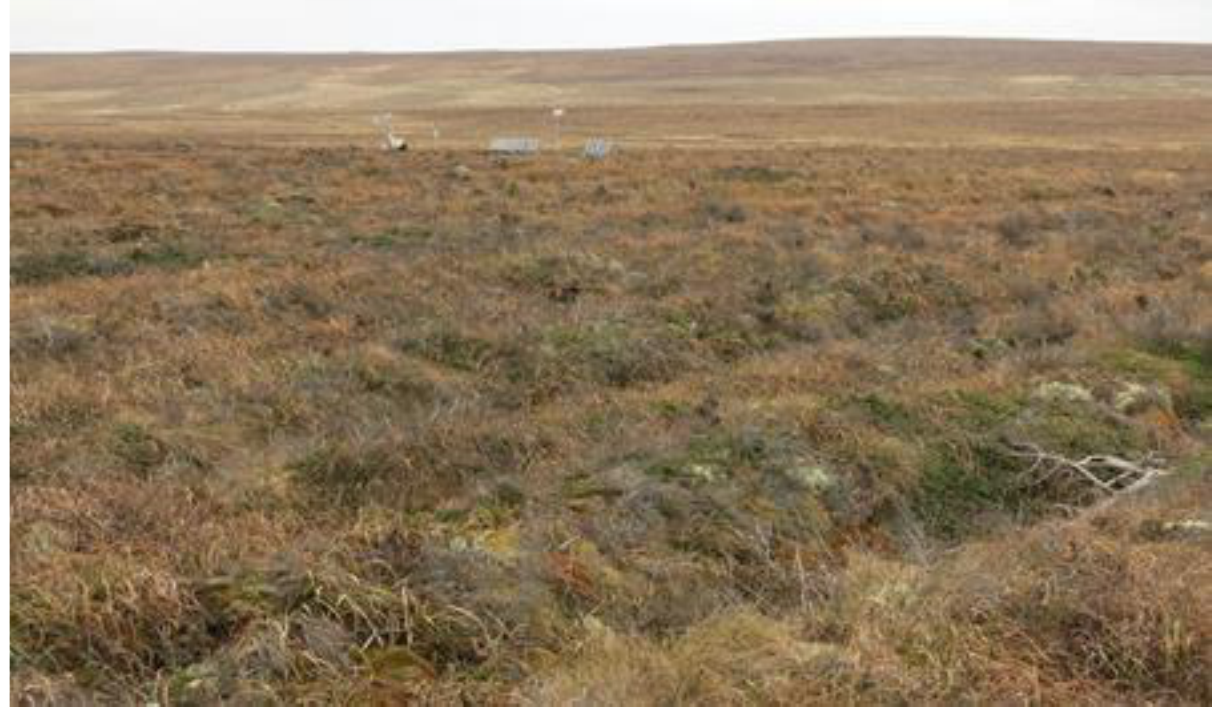
Figure 2. The Talaheel site with taller vegetation, such as Eriophorum spp. , present on the site . The microtopography on the site is visible in the foreground while further back the eddy covariance set up on the site can be seen. Photo: Graham